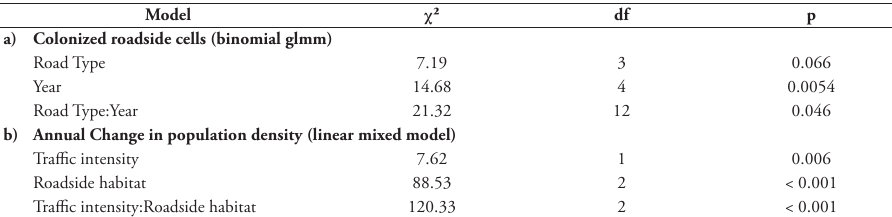
Table 1. Effects of a) Road type and year on the proportion of roadside cells colonized by Ambrosia arte- misiifolia and b) Traffic intensity and roadside habitat on annual change in population density of Ambrosia artemisiifolia in 49 roadside